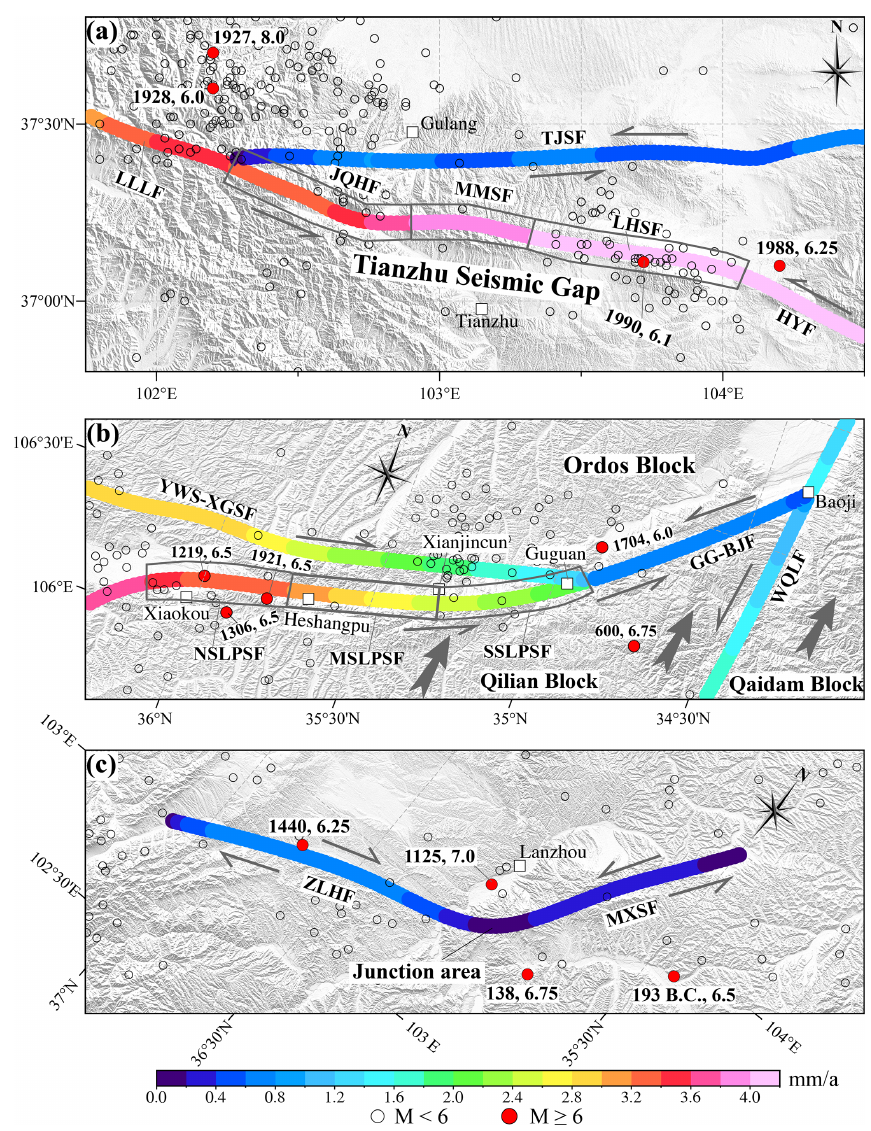
Figure 13. Modeled horizontal fault slip rates and distribution of historical earthquakes in (a) the Tianzhu seismic gap; (b) the intersection of the Liupanshan, Guguan–Baoji, and Yunwushan–Xiaoguanshan faults; and (c) the junction of the Maxianshan and Zhuanglanghe faults. The gray arrows in (b) represent the movements of the Qilian and Qaidam blocks, and NSLPSF, MSLPSF, and SSLPSF are the northern, middle, and southern segments of the Liupanshan Fault,